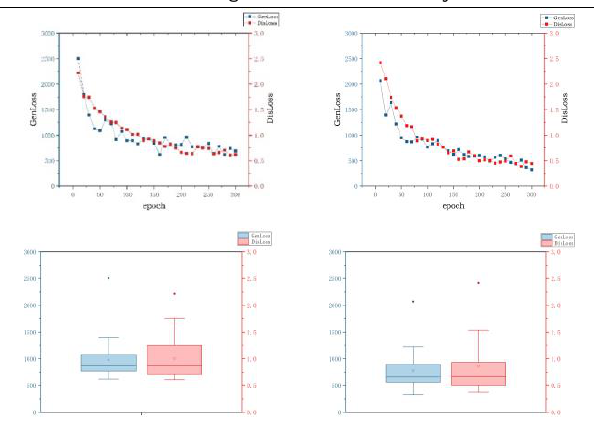
Figure 3. The curves and box plots in each experiment